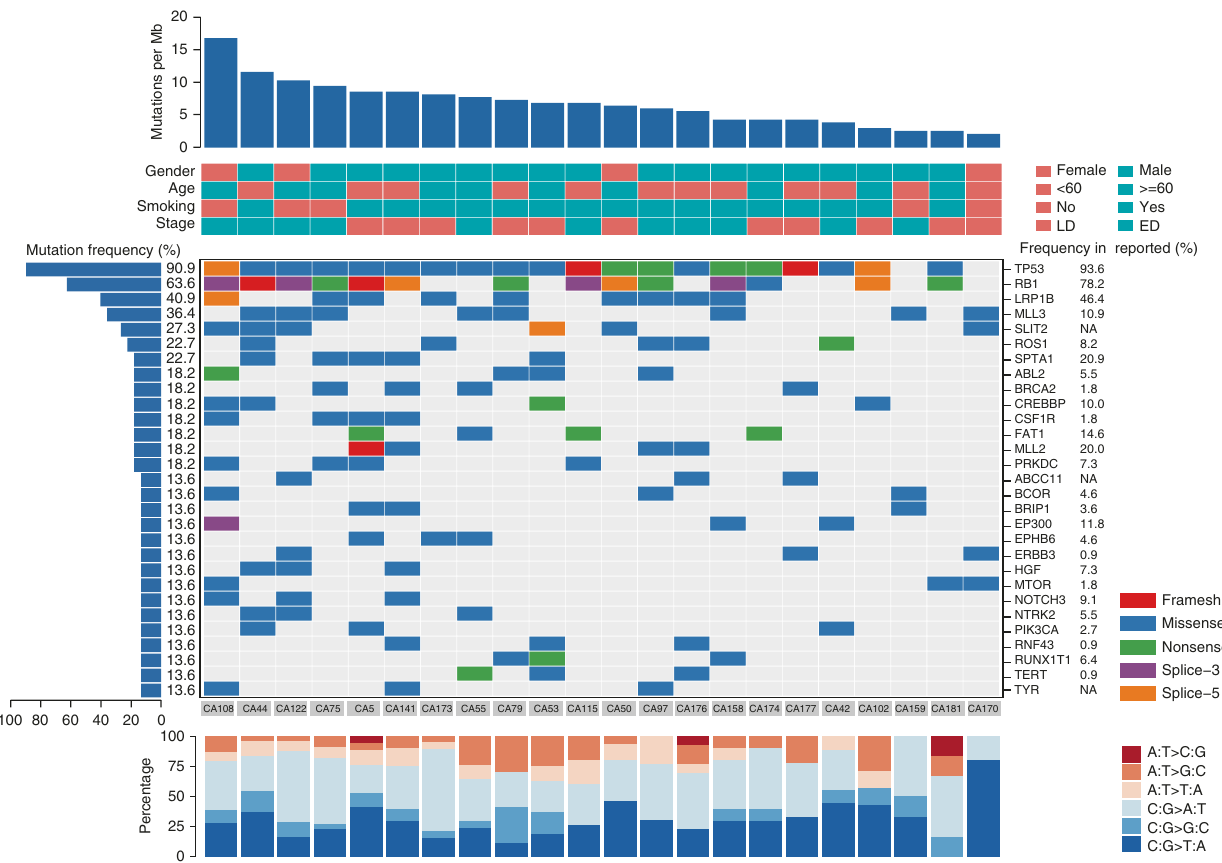
Fig. 1 Somatic mutation pro fi les of 22 SCLC patients from pre-treatment ctDNA sequencing of 430 cancer genes. Twenty-two patients were arranged along the x -axis. Mutation per Mb region, clinical and pathological characters were shown in the upper panel. Genes with somatic mutations were shown in the middle panel. Mutation frequencies of each gene were shown on the left and mutation frequencies of these genes in previous report 12 were shown on the right to each gene. The mutational spectrum was shown at the